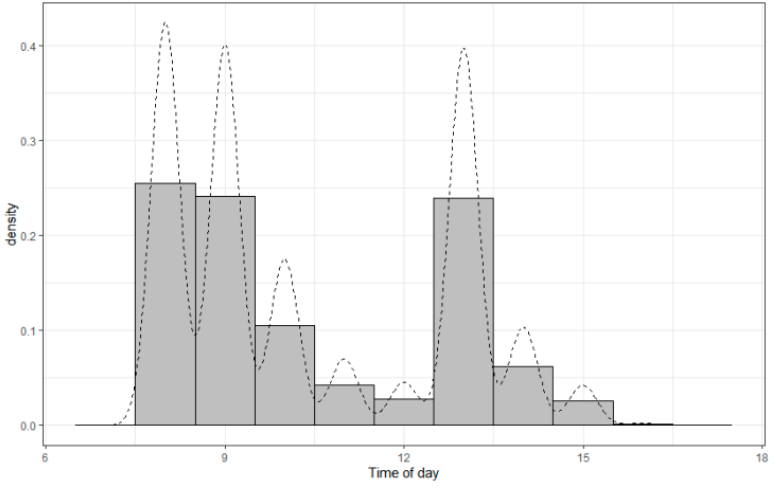
Figure 3. The sedation start time was trimodal, peaking at 8:00–9:00 A.M., 9:00–9:59 A.M., and 13:00–14:00 P.M.